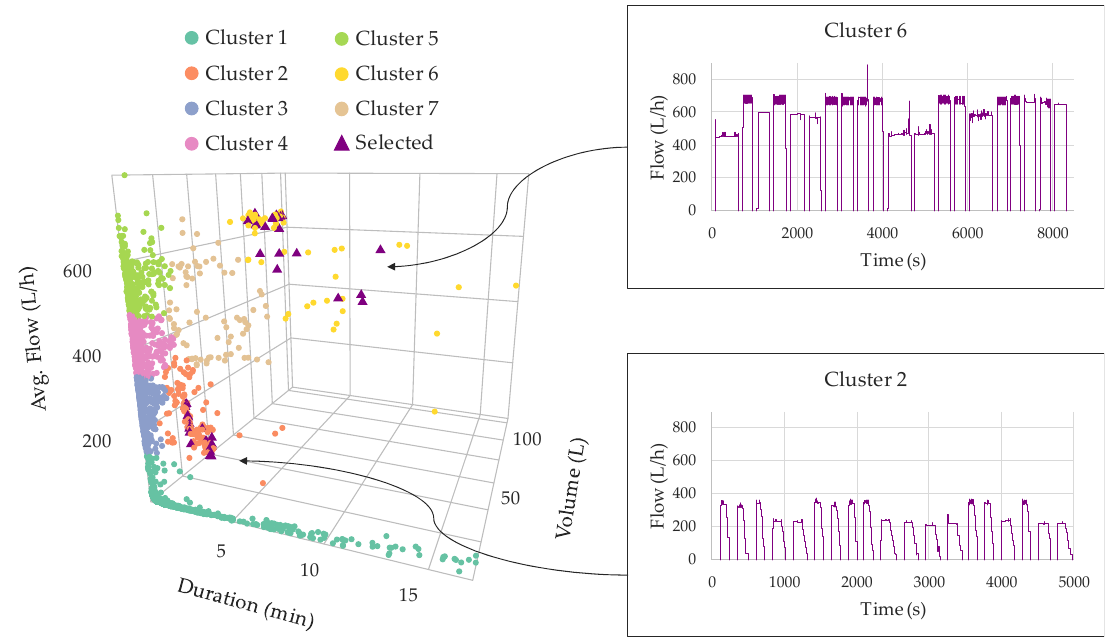
Figure 10. Display of 20 randomly selected individuals from clusters 2 and 6 for household HH-06 that belongs the R1 study.